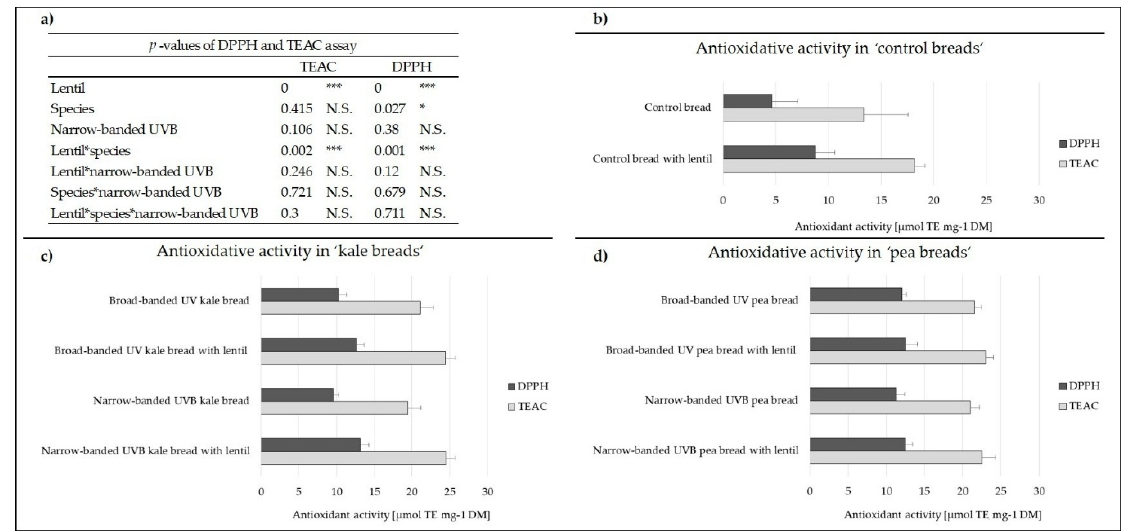
Figure 1. Total antioxidant activity in µmol trolox equivalent (TE) mg − 1 DM including p -values (N.S. = not significant). a ) p -values, b ) control breads, c ) ‘kale breads’, and d ) ‘pea breads’. * = p -value < 0.01 and *** = p -value < 0.005.